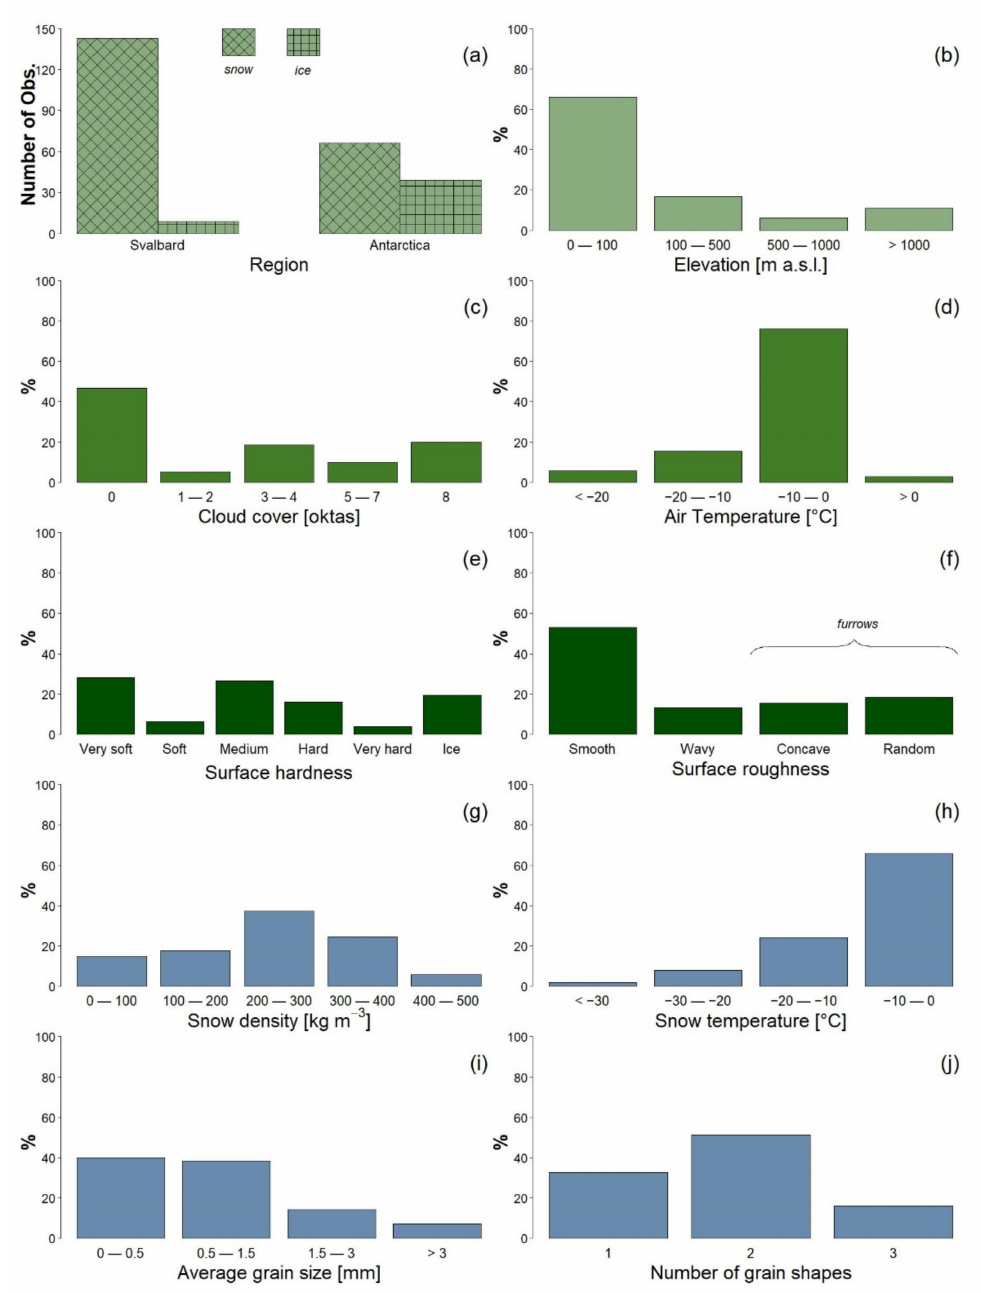
Figure 8. Summary plot of observations: ( a ) region of interest, ( b ) site elevation, ( c ) cloud cover during the acquisition, ( d ) air temperature, ( e ) surface hardness, ( f ) surface roughness, ( g ) snow density, ( h ) snow temperature, ( i ) average snow grain size, and ( j ) number of identified snow crystal